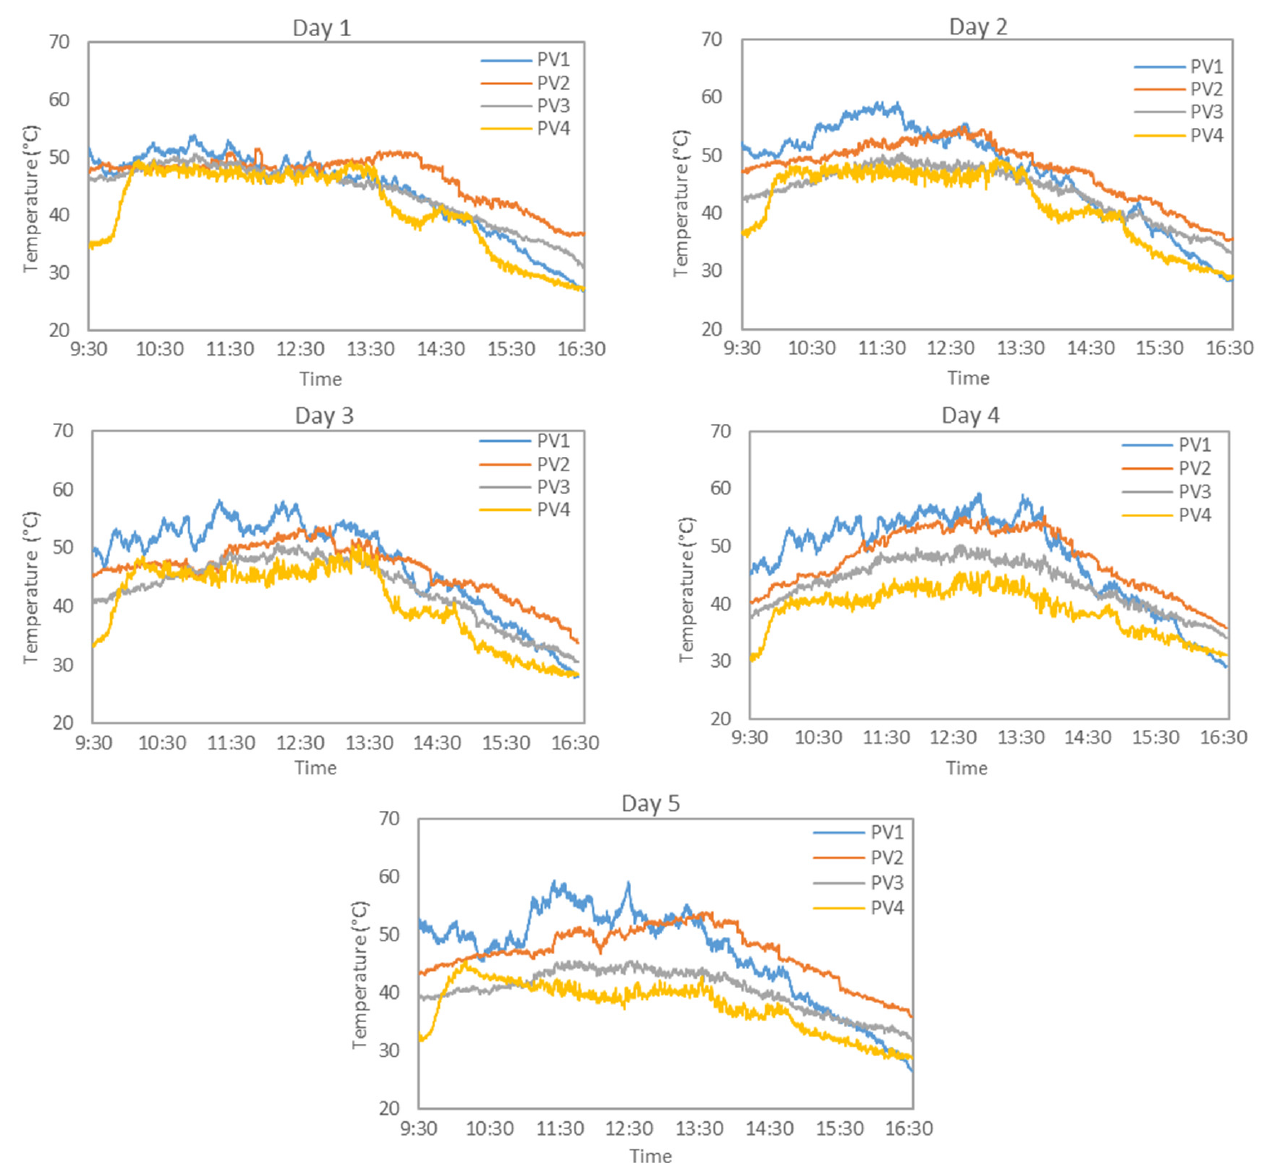
Figure 6. The average temperatures of the four PV panels measured at the back of the cells for 5 days in October 2022.